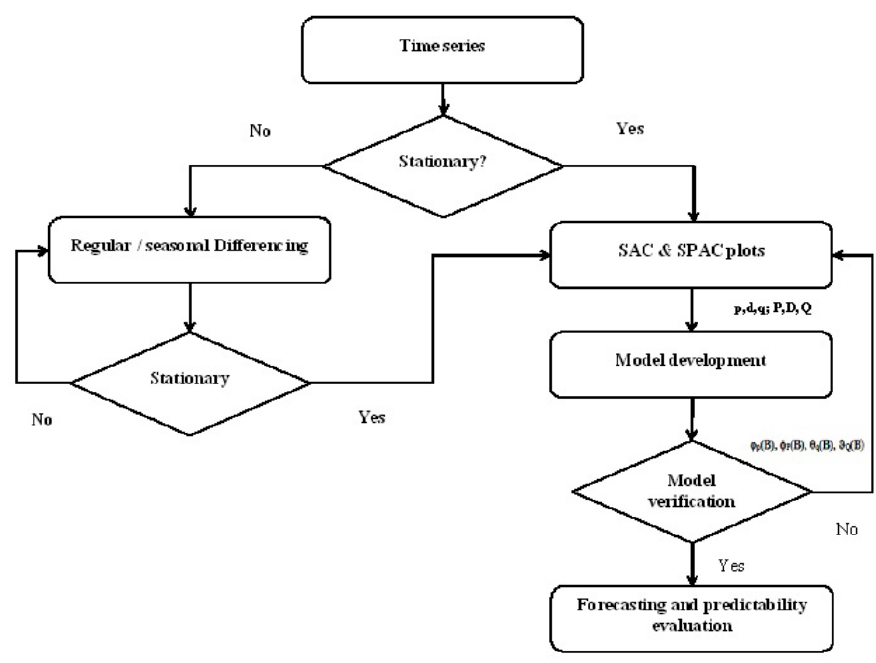
Figure 3. Autoregressive integrated moving average (ARIMA) model development process.